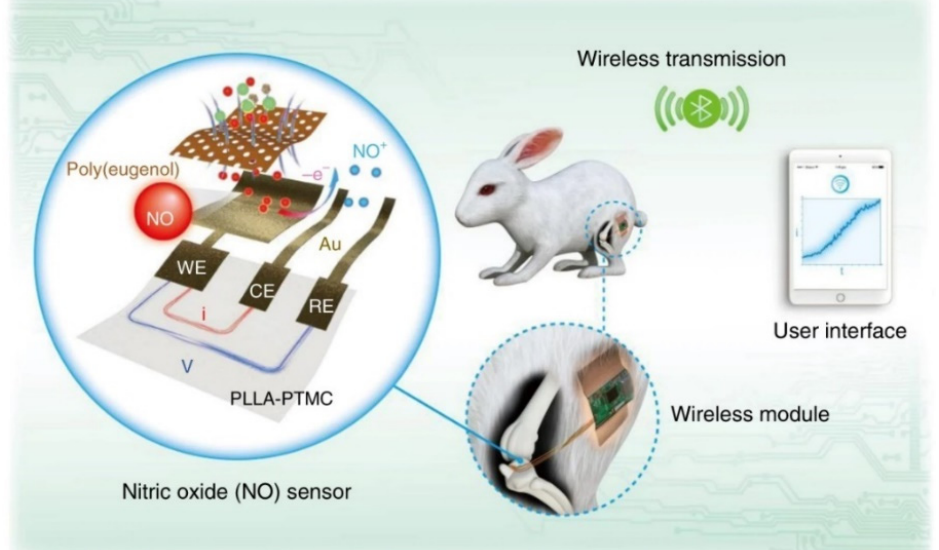
Figure 8. Schematic illustration of a transient NO sensor composed of a bioresorbable substrate (copolymer of poly( L -lactic acid) and poly(trimethylene carbonate)), Au nanomembrane electrodes, and a poly(eugenol) thin film. The sensor implanted in the joint cavity of a New Zealand white rabbit allows for continuously detecting NO concentrations in vivo and transmitting the data to a user interface through a customized wireless module. Reprinted from